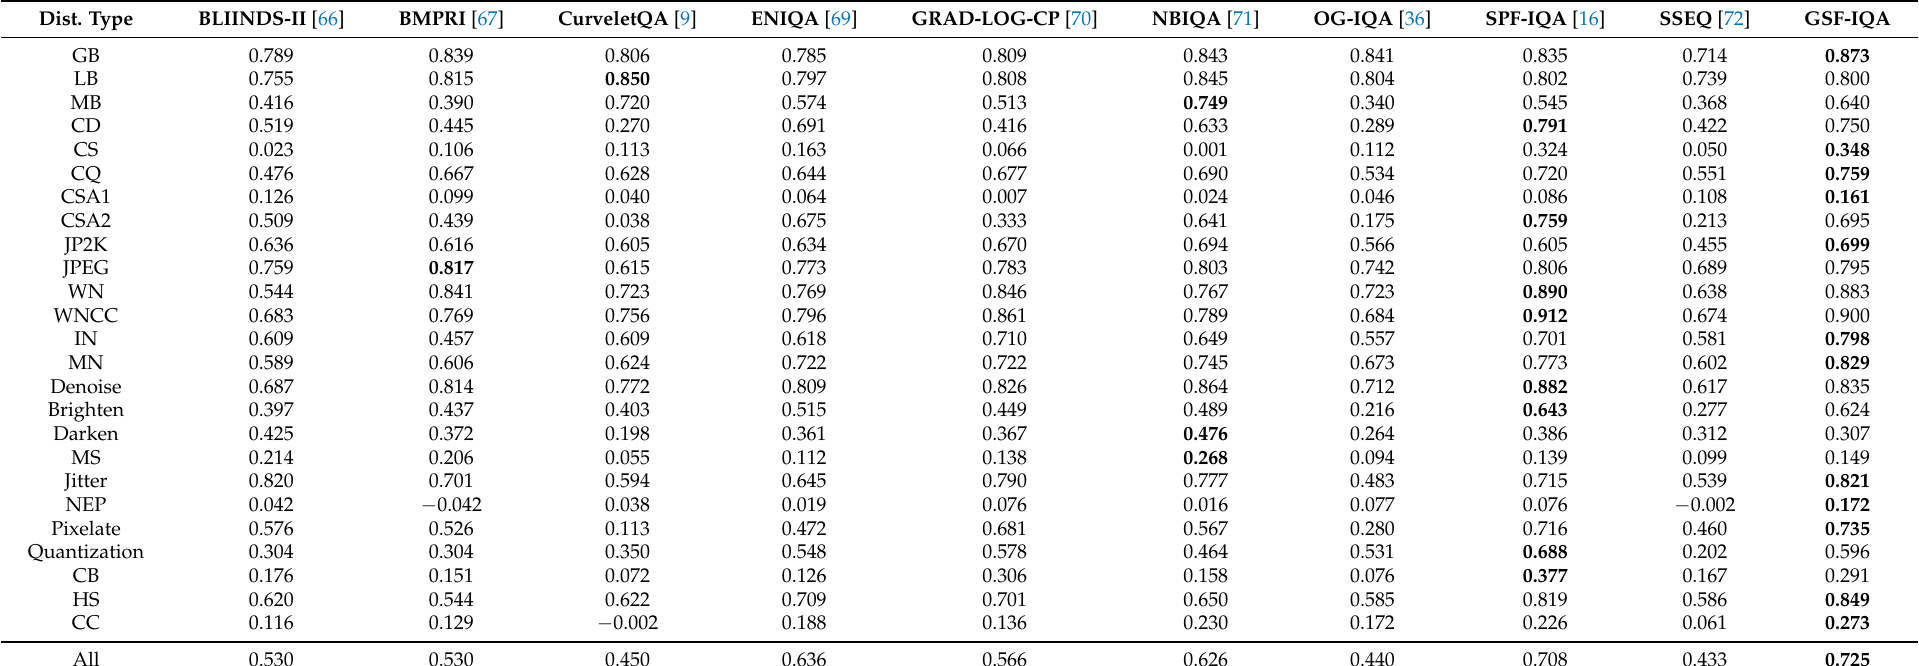
Table 9. Mean SROCC value comparison on different distortion types of the KADID-10k [46] database. Measured over 100 random train–test splits with respect to the reference images. The best results are typed in bold.